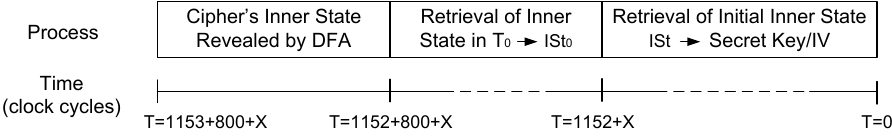
Figure 7. Representation of the secret key and IV recovery